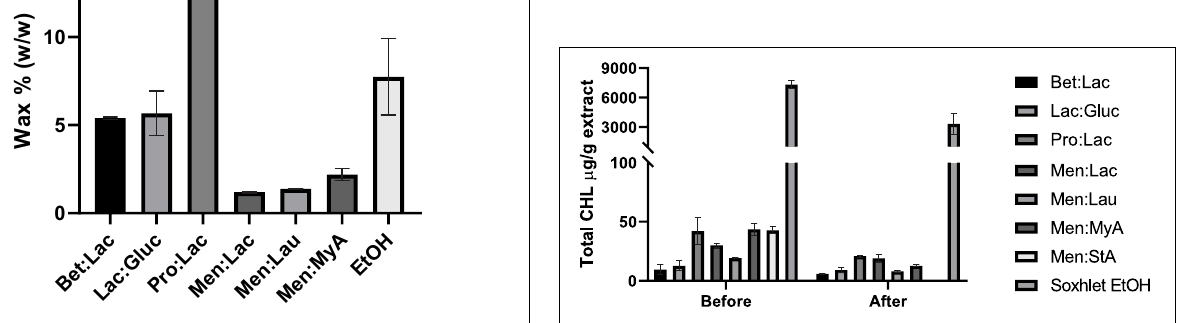
FIGURE 5 | Results of wax quantification (%) of hemp extracts related to the different extraction solvents.